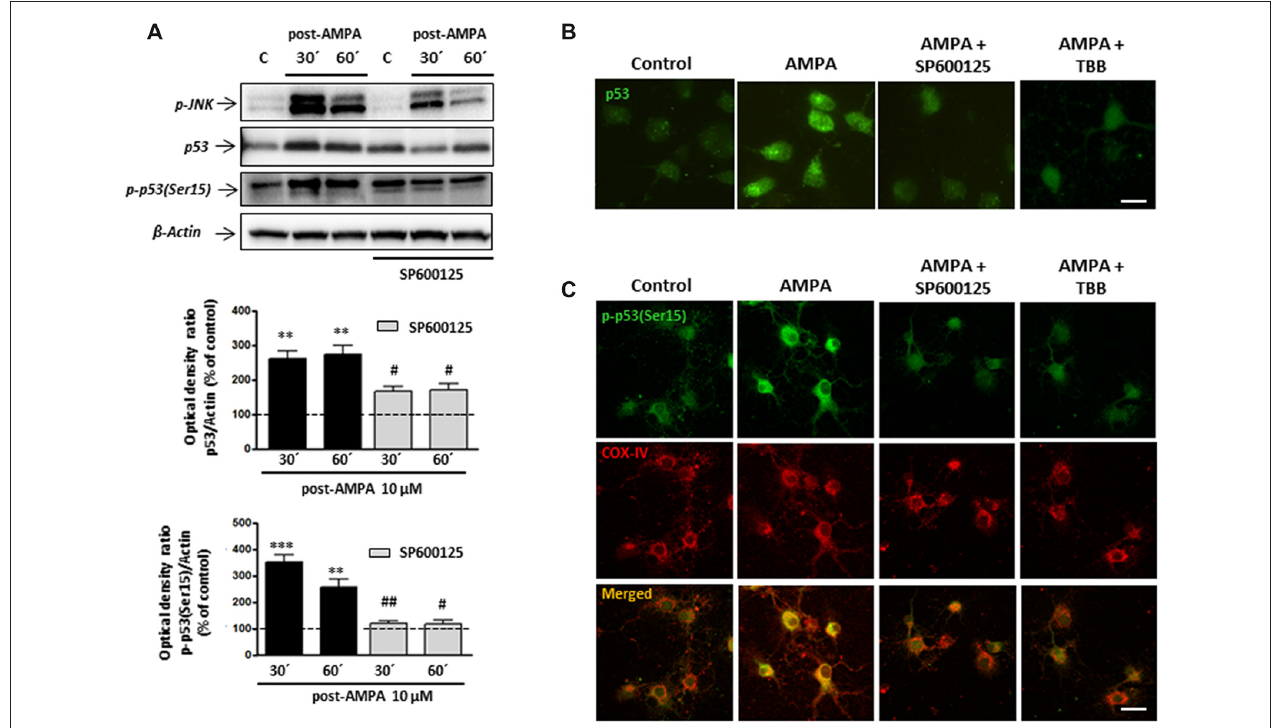
FIGURE 9 | Phosphorylation of p53 at Ser15 induced by AMPA is JNK/CK2 dependent. Oligodendrocytes were treated for 30 min with 10 µ M AMPA plus 100 µ M CTZ, in absence or presence of JNK or CK2 inhibitors, and the different assays were carried out at the indicated times. (A) WB analysis of total p53 and p-p53(Ser15) at 30 and 60 min after excitotoxic stimulus, in absence or presence of 1 µ M SP600125. Exposure to AMPA induced an increase in expression levels of both total p53 and p-p53(Ser15), which were abolished by the JNK-inhibitor SP600125. The level of JNK phosphorylation was used as a control of the effectiveness of the treatment and β -actin was the internal loading control. ∗∗ p < 0.01, ∗∗∗ p < 0.001 (cells treated with AMPA respect to control cells); # p < 0.05, ## p < 0.01 (cells treated with SP600125 respect to cells treated with only AMPA, at the same time). (B) AMPA triggered increases in p53 expression level, revealed with an antibody against total p53, which was reverted by JNK inhibitor SP600125 and CK2 inhibitor TBB. Scale bar: 10 µ m. (C) Cells were treated with AMPA, as indicated above, in the presence of SP600125 or TBB and fixed at 30 min after stimulus. Immunofluorescence analysis using the specific antibody against p-p53(Ser15; green) showed that AMPA-induced activation of p53 through its phosphorylation in Ser15 was not detected in presence of JNK or CK2 inhibitors and neither its mitochondrial accumulation (revealed by COX-IV antibody; red). Scale bar: 10 µ